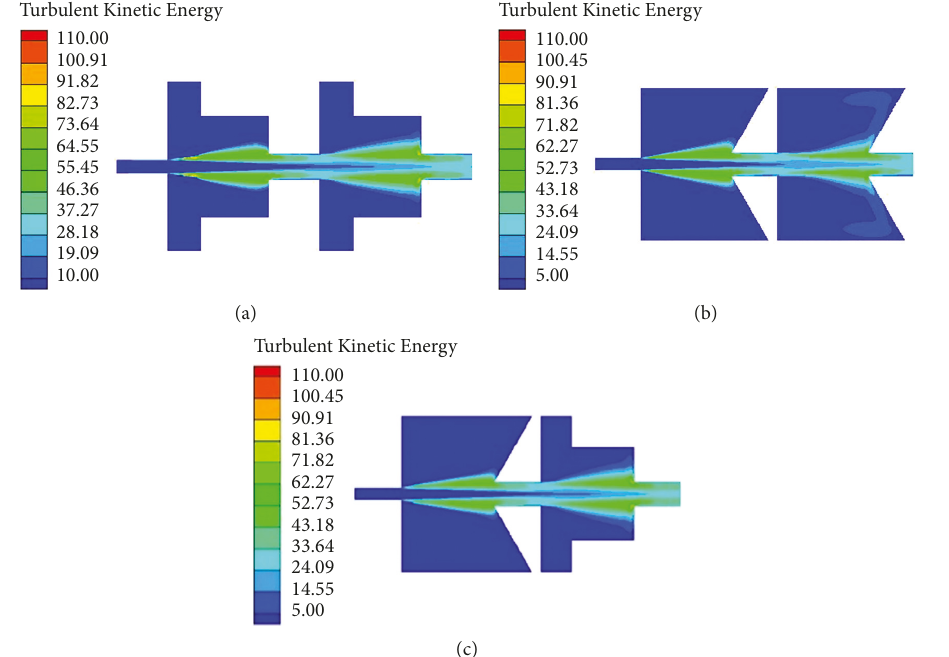
Figure 12: Cloud images of turbulent kinetic energy distribution and streamlines of dual-chamber self-excited oscillating pulsed nozzles. (a) Organ pipe + organ pipe, (b) Helmholtz + Helmholtz, and (c) Helmholtz + organ